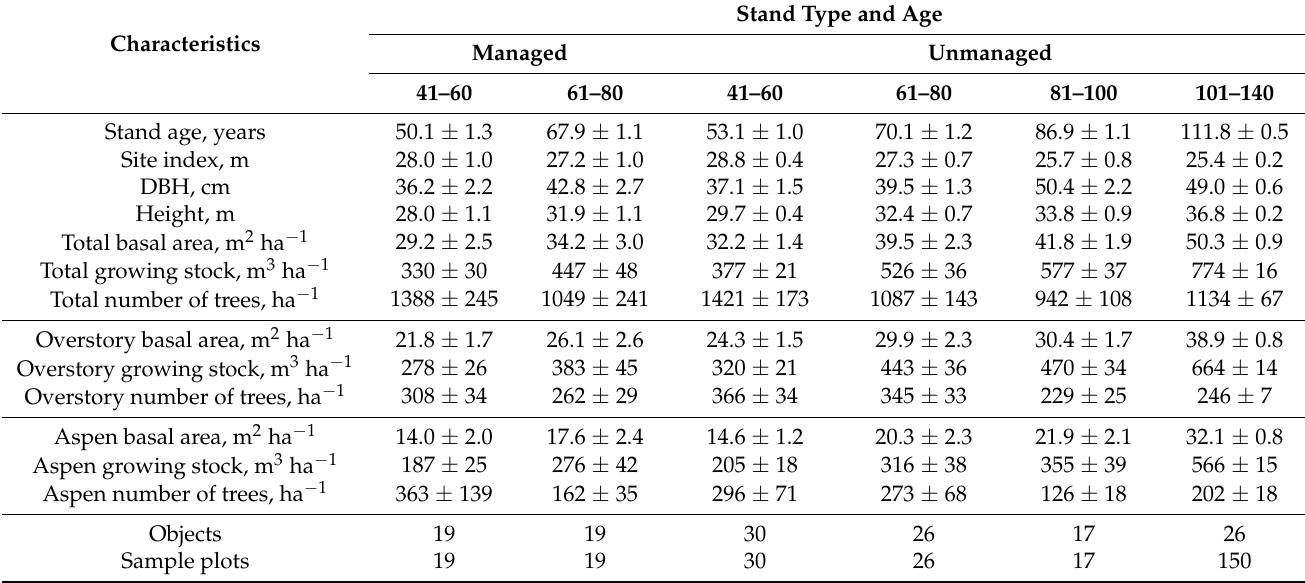
Table 3. Characteristics (marginal mean ± standard error) of mature (41–60 years), moderately overmature (61–80 years), overmature (81–100 years), and old-growth (101–140 years) European aspen ( Populus tremula L.) stands according to management